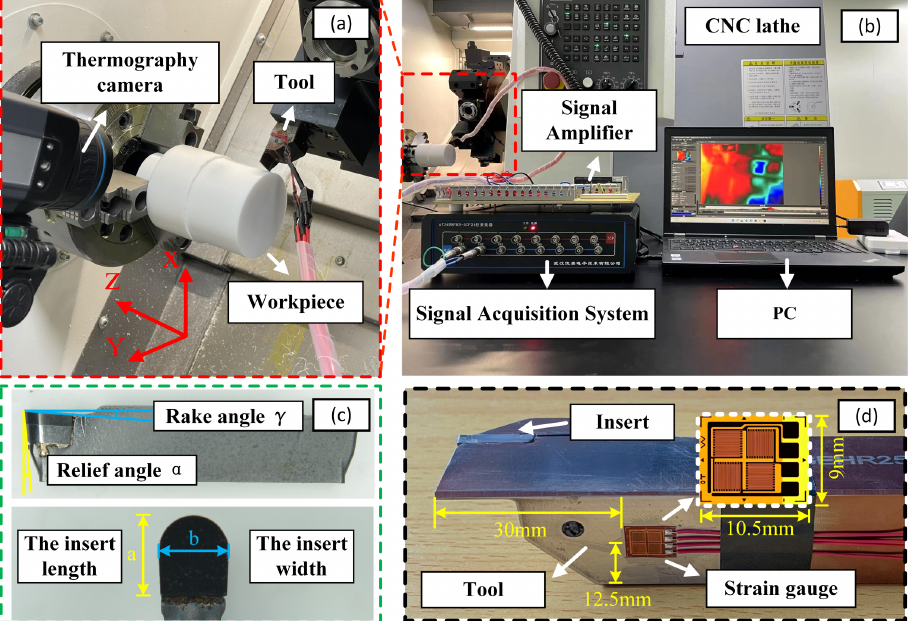
Figure 1. Experimental setup: ( a ) cutting area; ( b ) signal acquisition system; ( c ) parameter diagrams of the curvilinear profile tool; and ( d ) sensor